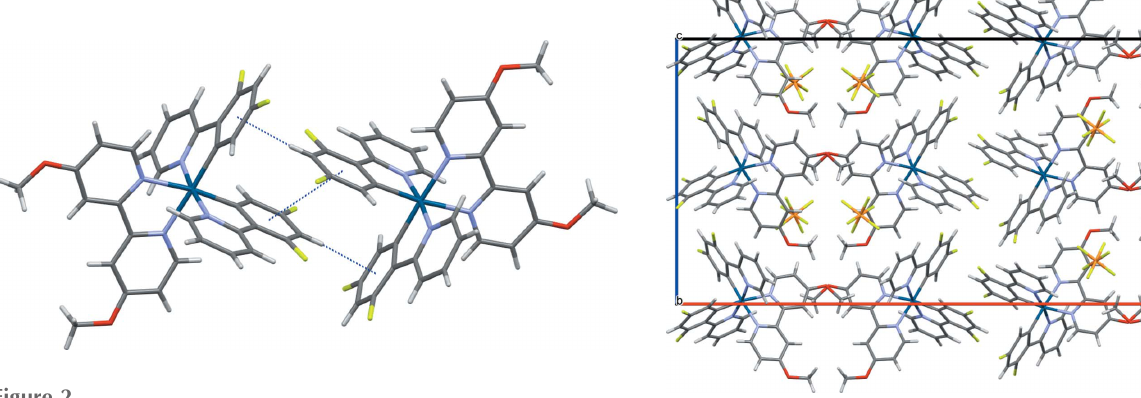
Figure 2 Dimers of the title complex formed via offset (cid:2) stacking and C—H (cid:4)(cid:4)(cid:4) (cid:2) interactions. The projection is viewed along [010].